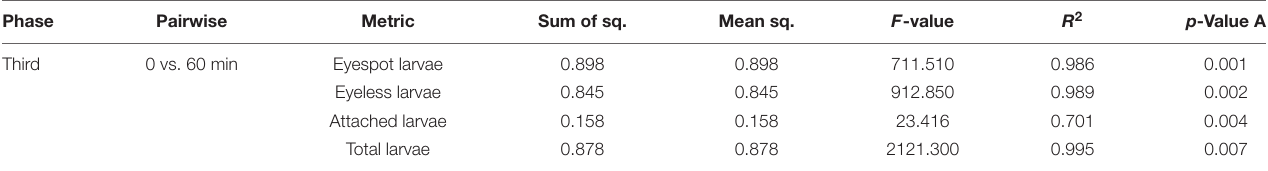
TABLE 9 | The density distribution of eyespot larvae, eyeless larvae, and total larvae and the number of attached larvae of the hybrid oyster to each TPC and the GMSCs patch (LX = 5 lx). RGB color